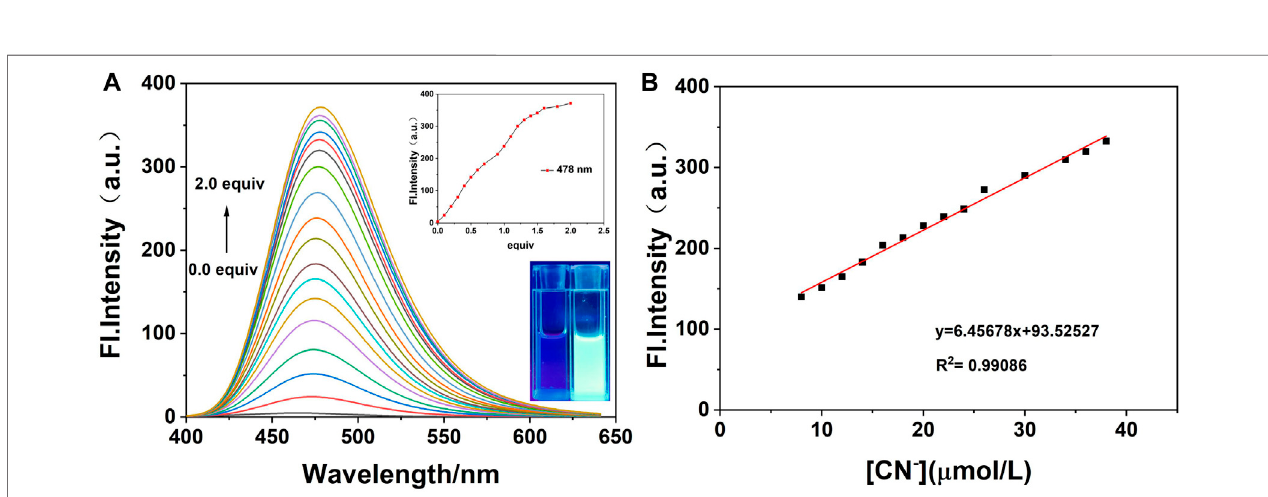
FIGURE 8 | (A) Fluorescence spectra on the addition of CN − to probe W (20 μ M); (B) linear curve of fl uorescence intensity ofprobe solution at λ max em = 478 nm and concentration of CN − (8~38 μ M). Inset: curve of fl uorescence intensity at λ max em = 478 nm with different concentrations of CN − ; photograph of the fl uorescence change under the irradiation of 365 nm UV lamp after the titration is complete.